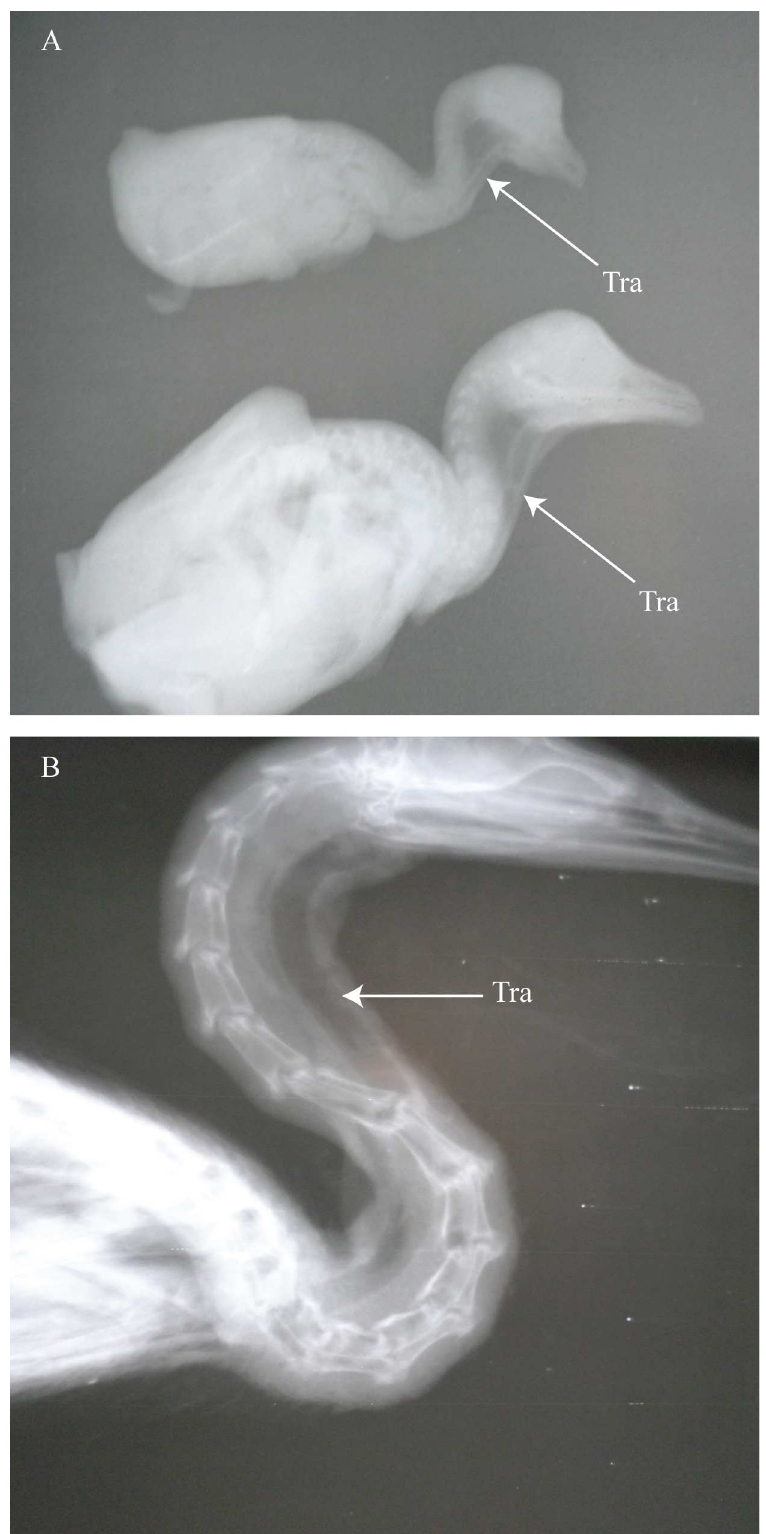
Fig 7. Phalacrocoraxauritus radiographs. (A) hatchlingdouble-crestedcormorants. (B) adult. Tra = trachea.